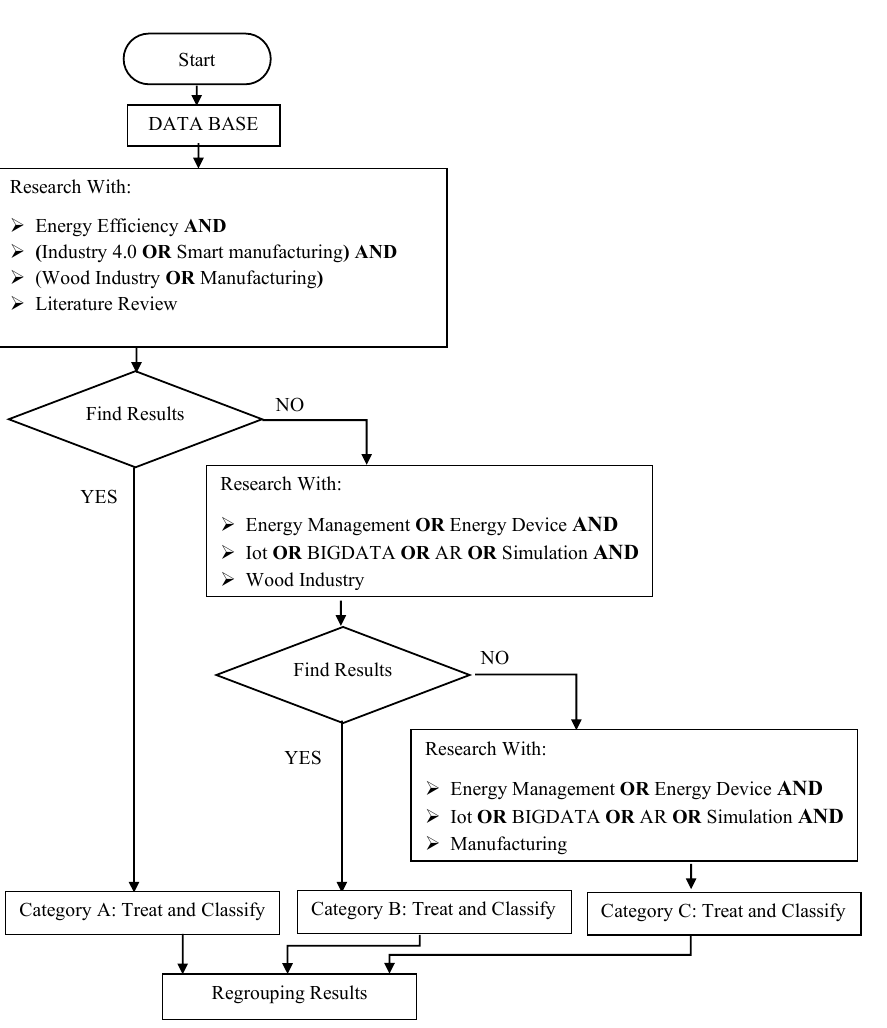
Scheme 2. Methodological diagram of the article search.